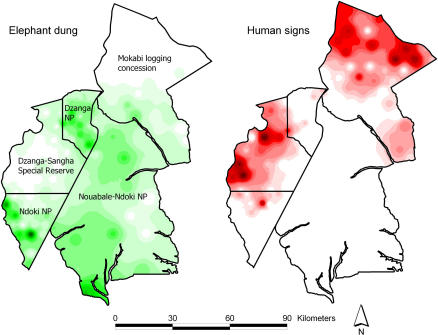
Interpolated Elephant Dung Count and Human-Sign Frequency across the Ndoki-Dzanga MIKE SiteIncreasing colour intensity signifies increasing dung and human-sign frequency.